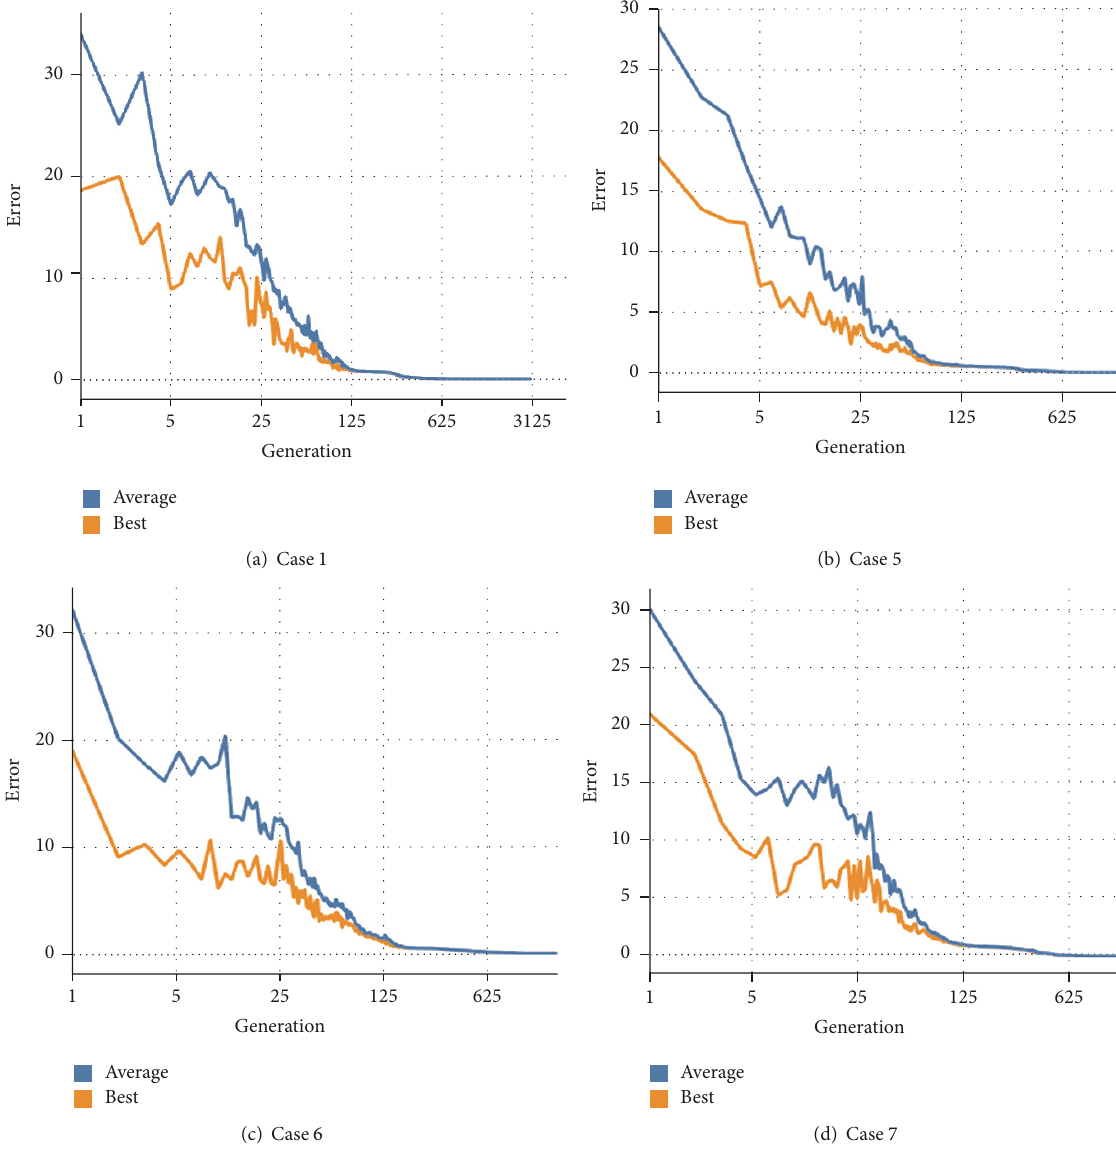
Figure 9: Line graph of showing prediction errors over the number of generations in CMA-ES on four test cases.